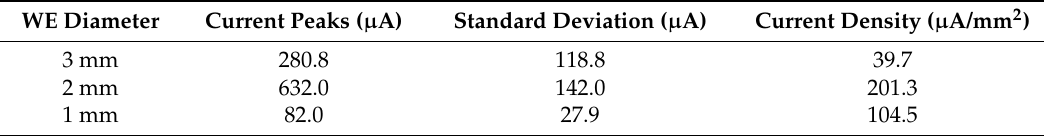
Table 3. Current peaks heights for 10 ng/mL protein quantification on the glass-substrate sensor. WE Diameter Current Peaks ( µ